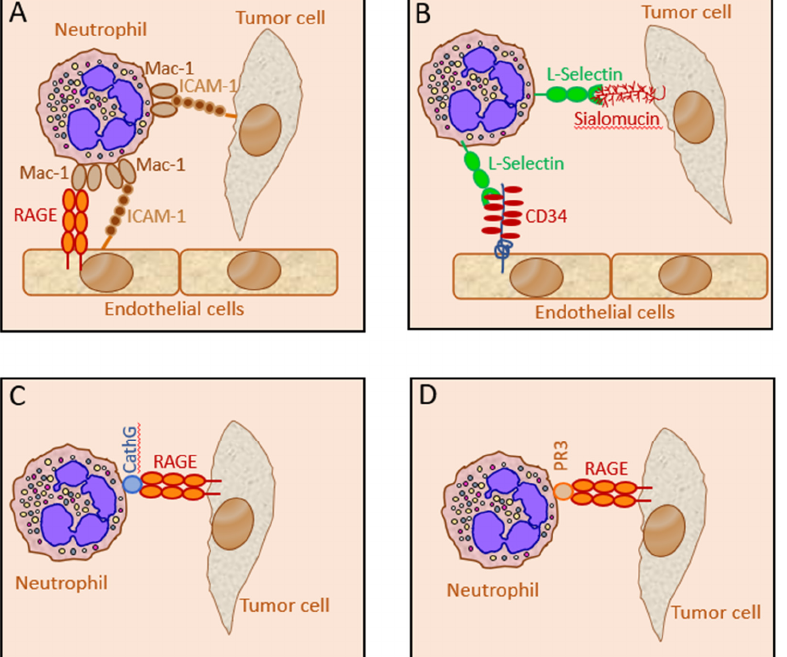
Figure 5. Characterized neutrophil–tumor cell recognition mechanisms. ( A ). Mac-1 (CD11b/CD18) on neutrophils can interact with ICAM-1 on certain tumor cells and endothelial cells. In addition, Mac-1 can interact with RAGE on endothelial cells. The neutrophils form a bridge between the tumor cells and endothelial cells, thus facilitating metastatic seeding. ( B ). L-Selectin on neutrophils can interact with sialomucin on certain tumor cells and CD34 on endothelial cells. Here, the capture of tumor cells by neutrophils that simultaneously interact with endothelial cells enables metastatic seeding. ( C ). CathG on neutrophils can interact with RAGE on tumor cells. This interaction has been shown to be important for executing the killing of RAGE-proficient tumor cells. ( D ). Proteinase 3 (PR3), which is expressed on the neutrophils, can interact with RAGE on tumor cells and induce proliferation of the tumor cells.